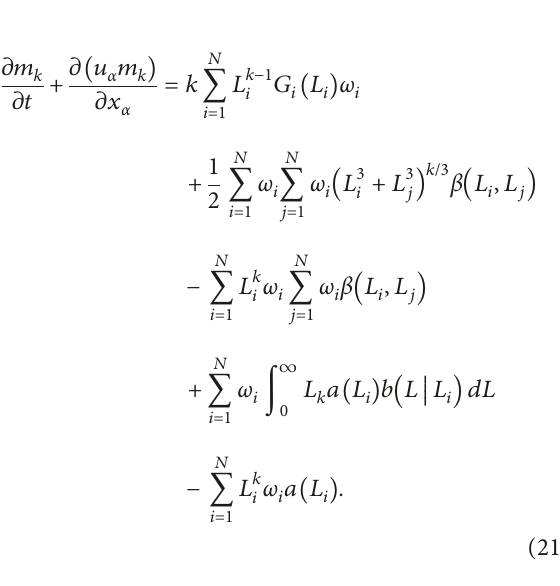
Figure 1: CFD-PBM coupled